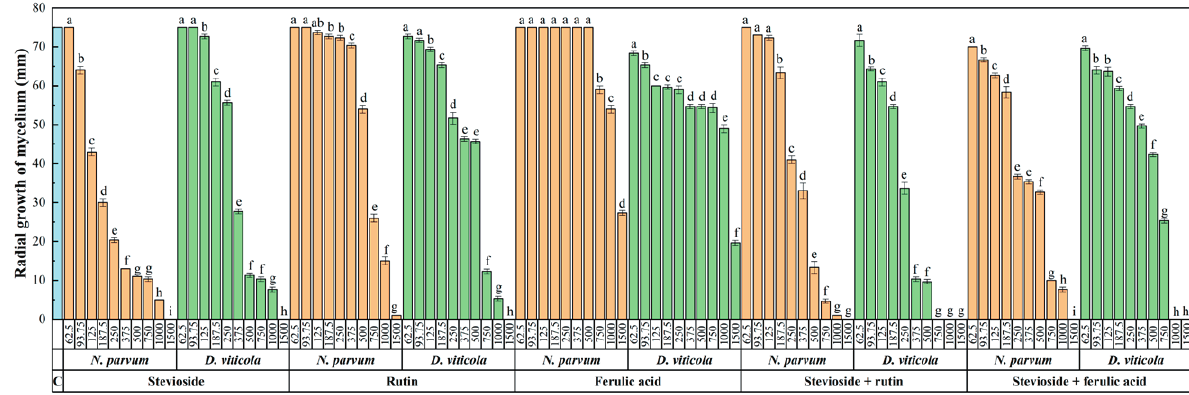
Figure 1. Mean colony radial diameters for Neofusicoccum parvum and Dothiorella viticola strains when cultured in PDA plates containing the different treatments) at concentrations ranging from 62.5 to 1500 μg·mL -1 . Means accompanied by the same letters are not significantly different ( P < 0.05), and bars indicate standard